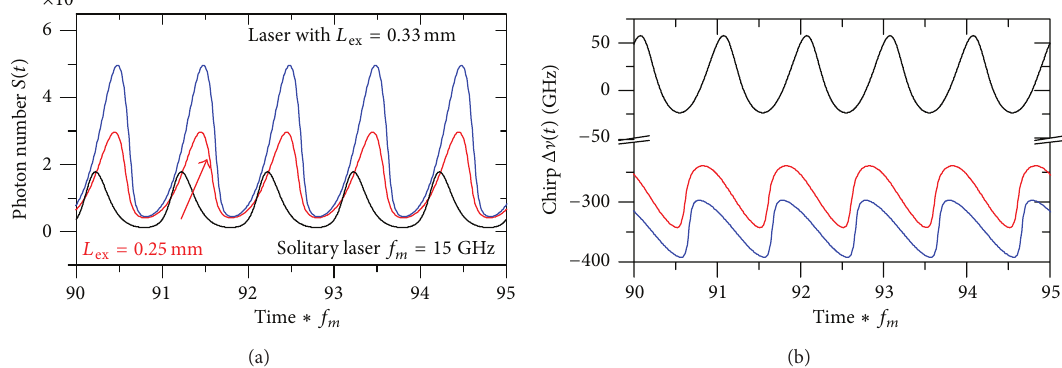
Figure 3: Modulation characteristics of the laser under OFB with 𝐿 and the solitary laser with 𝑓 𝑚 = 15 GHz: (a) modulated waveform 𝑆(𝑡) and (b) frequency chirp Δ ] (𝑡) .